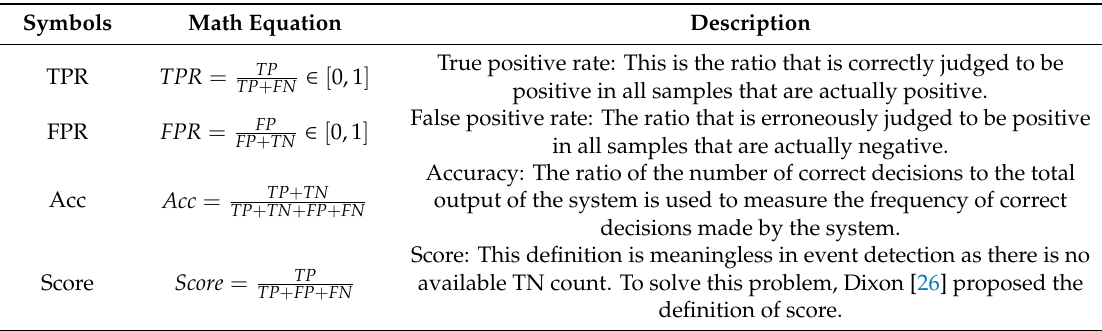
Table 8. The measurements to evaluate event